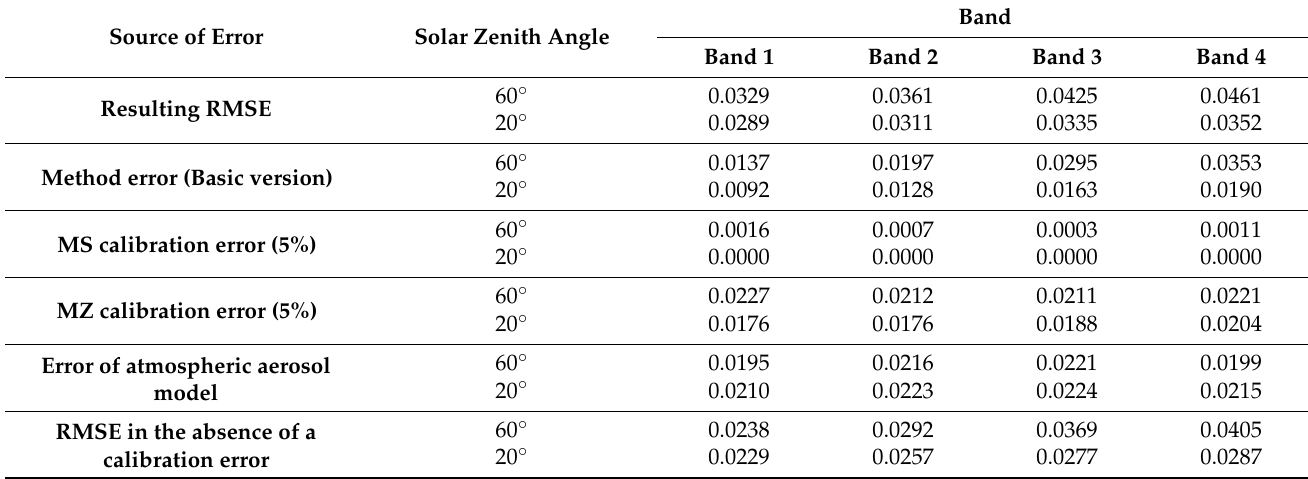
Table 13. Resulting RMSE of surface reflectance retrieval in the MZ channels and the contribution of various sources of error. Case with a bright underlying